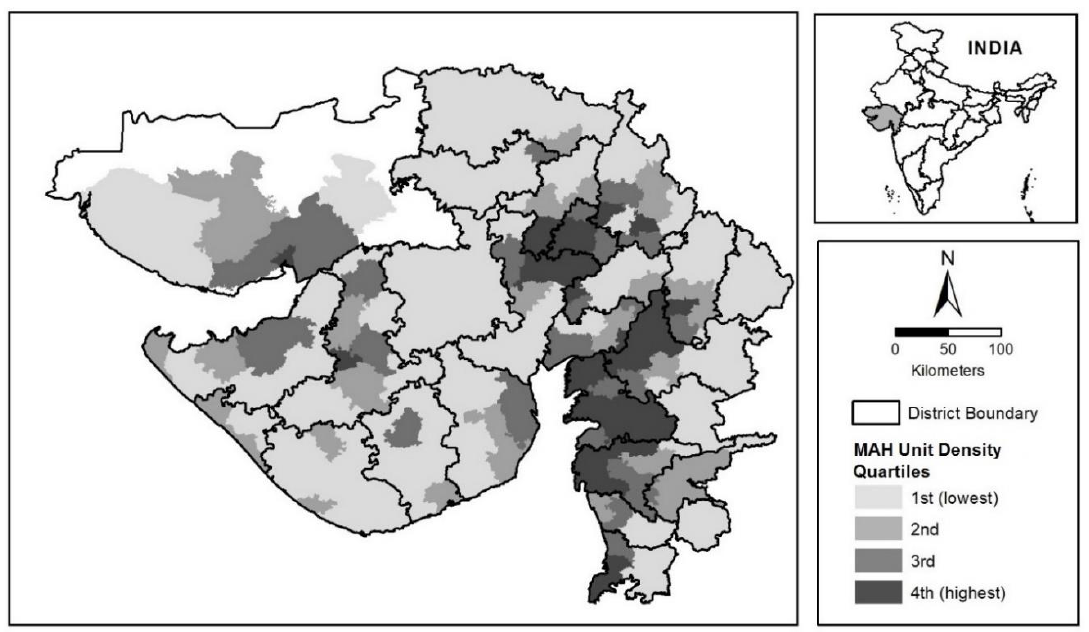
Figure 1. Distribution of MAH unit density by subdistrict and location of Gujarat, India.